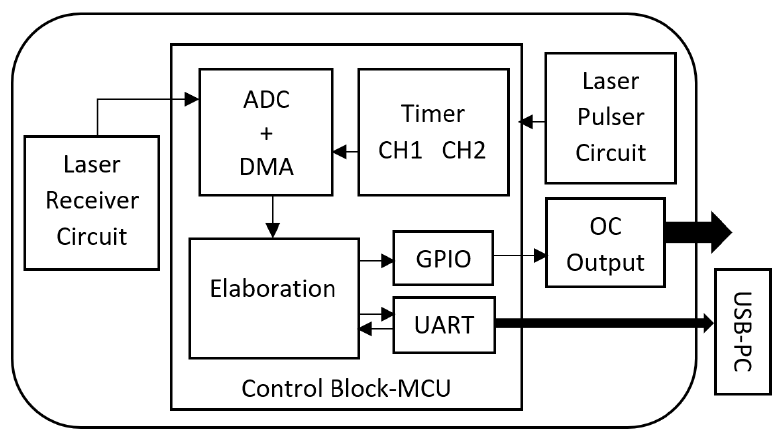
Figure 1. Block diagram of the proposed reflective-type displacement sensor.